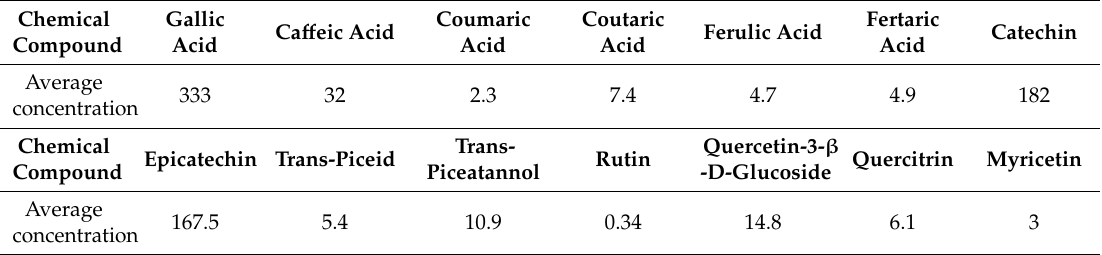
Table 3. Average content of selected antioxidant components in the Cerason variety in 2015–2017. The results are expressed in µ g / g of dry